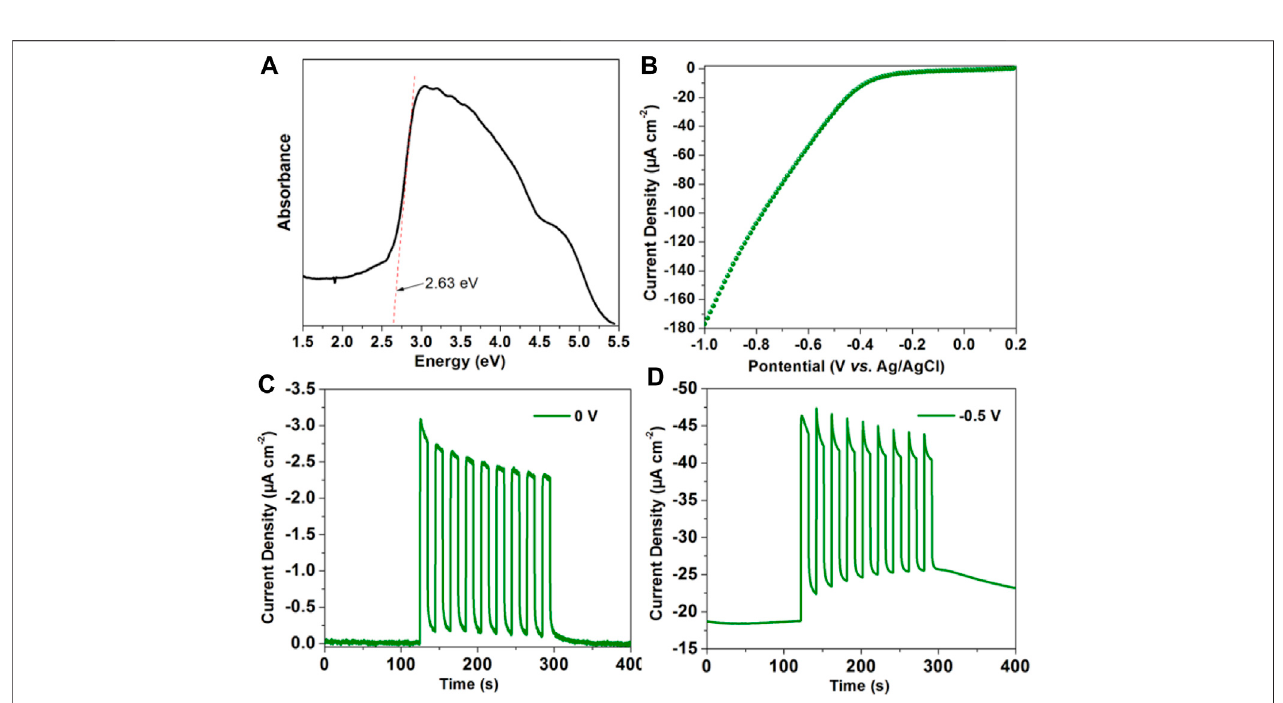
FIGURE 5 | (A) UV-VIS-NIR absorption of as synthesized [(DCPA) (AD) 2 ]. (B) The linear sweep voltammetry curve of as synthesized [(DCPA) (AD) 2 ] modi fi ed ITO electrodemeasuredin0.5 MNa 2 SO 4 aqueoussolution.Transientcurrentdensity – timecurveof[(DCPA)(AD) 2 ]atbiaspotentialof0 V (C) and − 0.5 V (D) withtheperiodic on-off cycles of light